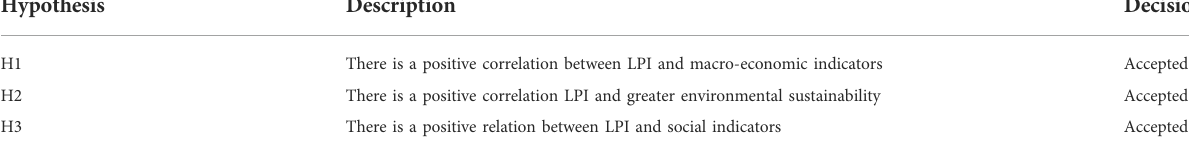
TABLE 6 Summary of Hypotheses decision across a panel of SSA countries.